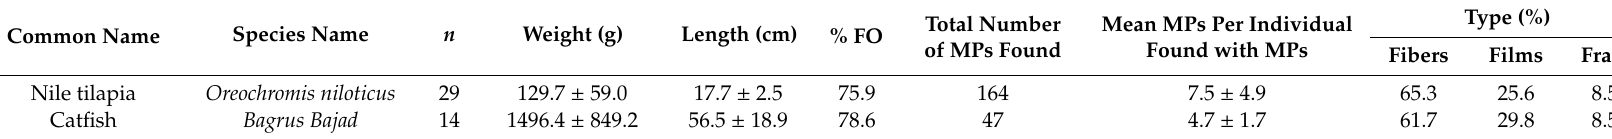
Table 1. Summary of data for Nile tilapia and catfish. The number of individual fish analyzed (n), average weights, and average lengths ( ± standard deviation) are provided. The frequency of occurrence (in %) describes the number of fish with microplastics (MPs) present in their gastrointestinal tracts. The total numbers of MPs found per species and average per individual are given alongside a breakdown of the di ff erent MP types found (in %). The full dataset of MPs found in each individual fish can be found in Supplemental Information (Table